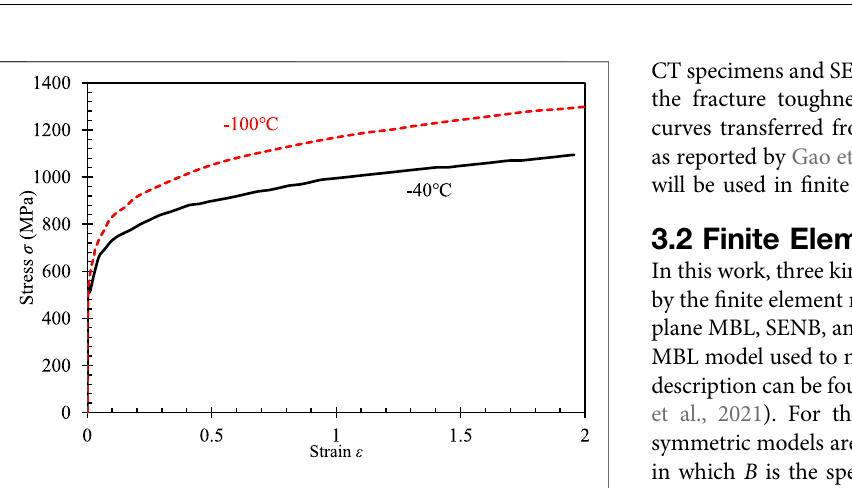
FIGURE 2 | Illustration of toughness scaling between specimen con fi gurations A and B based on the Weibull stress. (A) Loading J-integrity vs. Weibull stress. (B) Scaled fracture toughness from J cA to J cB .